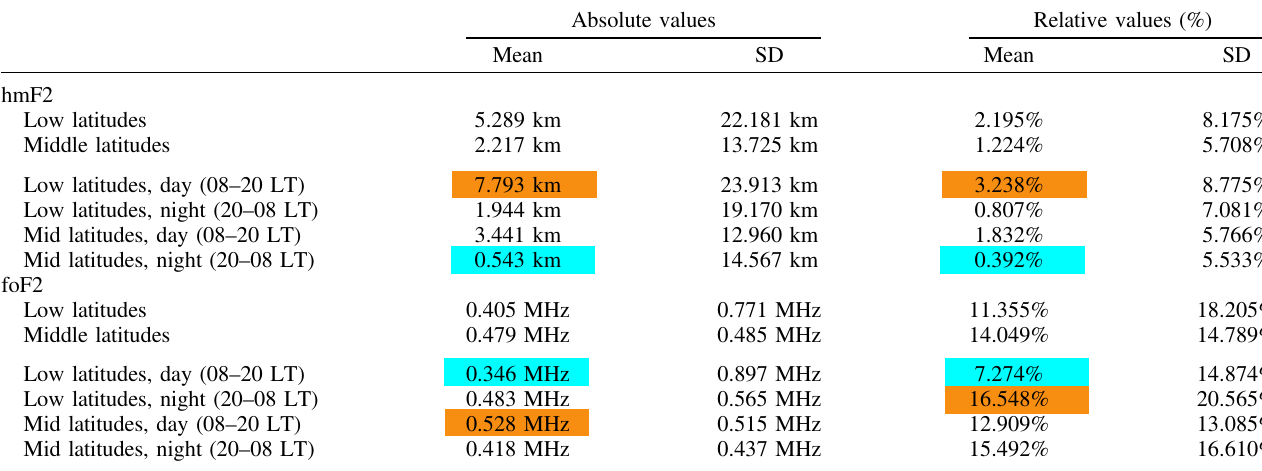
Table 2. Summary of the F2 peak parameters residuals D foF2 and D hmF2 between collocated COSMIC-2 and ionosonde measurements in absolute ( D X = X RO – X ionosonde ) and relative ( D X (%) = ( X RO – X ionosonde ) (cid:4) 100/( X ionosonde )) values. The dataset is subdivided into low/middle latitudes zones and daytime/nighttime conditions. Cells with orange and cyan shading show maximal and minimal values of the residuals mean,